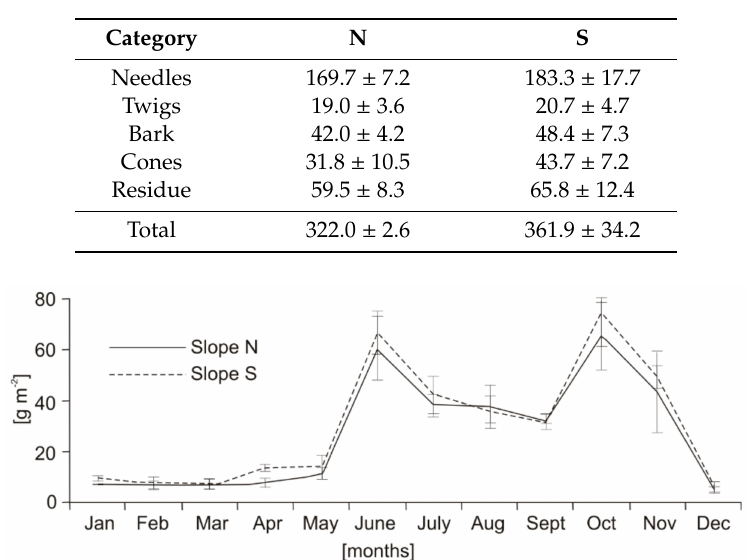
Figure 1. Averaged annual dynamics of total litterfall mass on slopes N and S (averaged for the three study years).